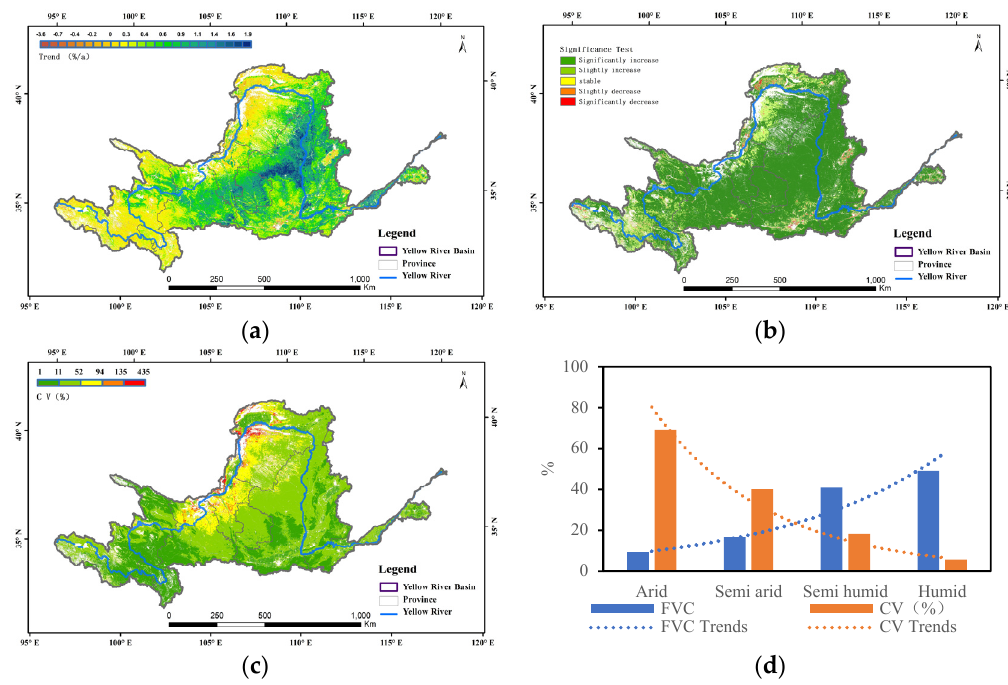
Figure 5. ( a ) Trends of FVC between 2000–2019. ( b ) Significance test of FVC trends. ( c ) The coefficient of variation (CV) of FVC changes in recent 20 years. ( d ) The mean and CV of FVC of dry and wet types in recent 20